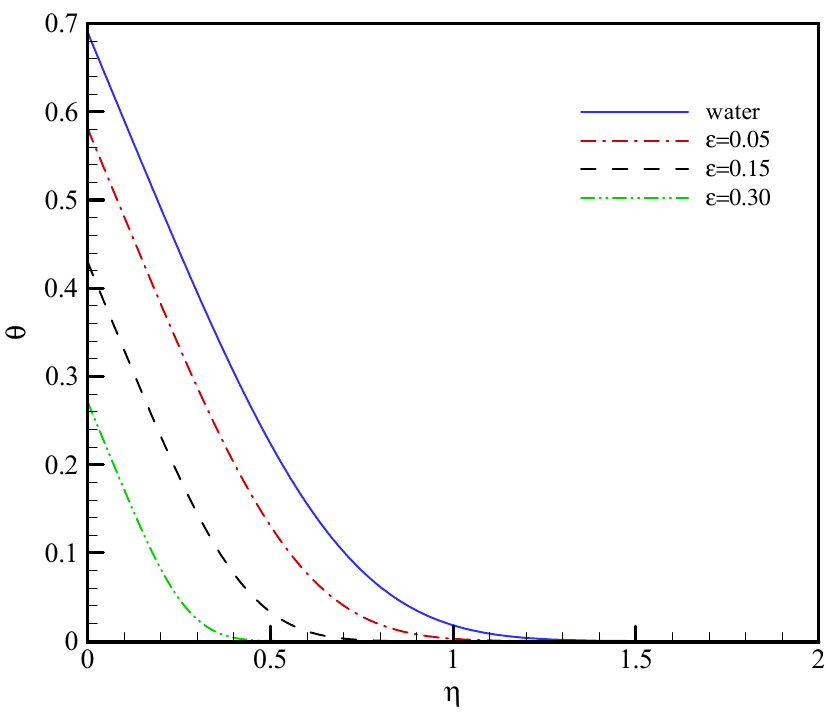
Figure 7. The effect of particle volume fraction of NEPCM slurry on the dimensionless temperature profiles in boundary layer.